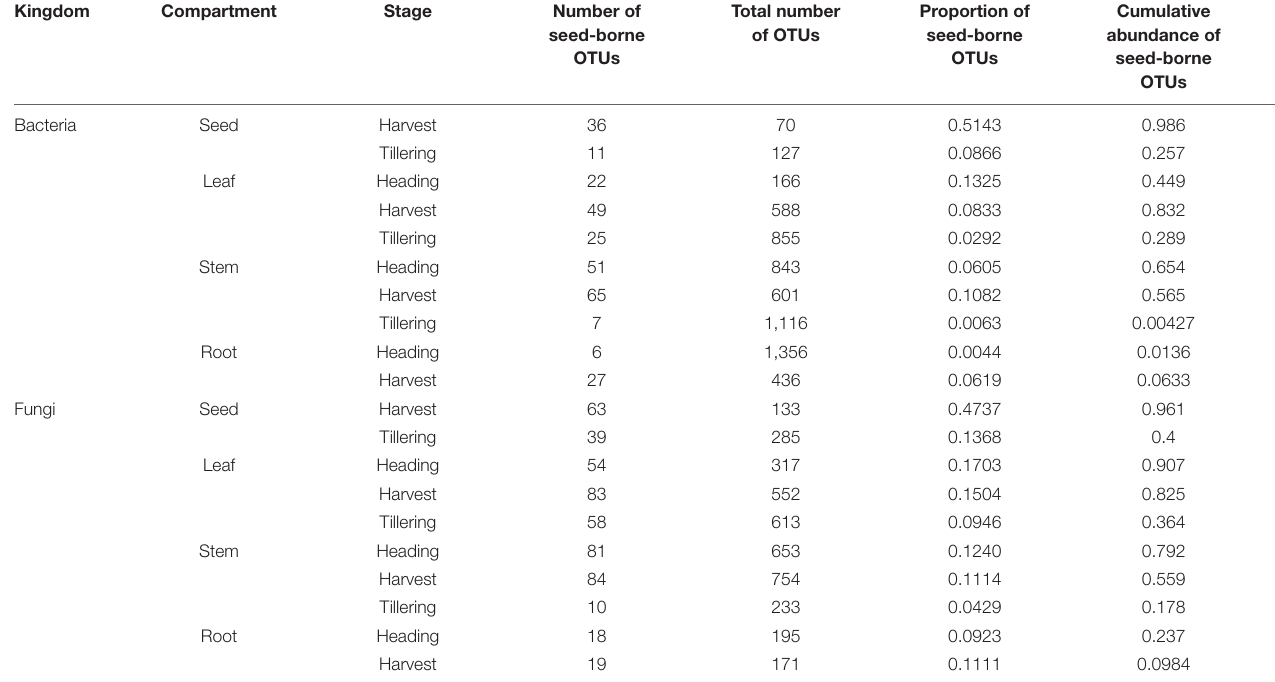
TABLE 1 | Seed-borne bacterial and fungal operational taxonomic units (OTUs) in the leaf, stem, root, and progeny